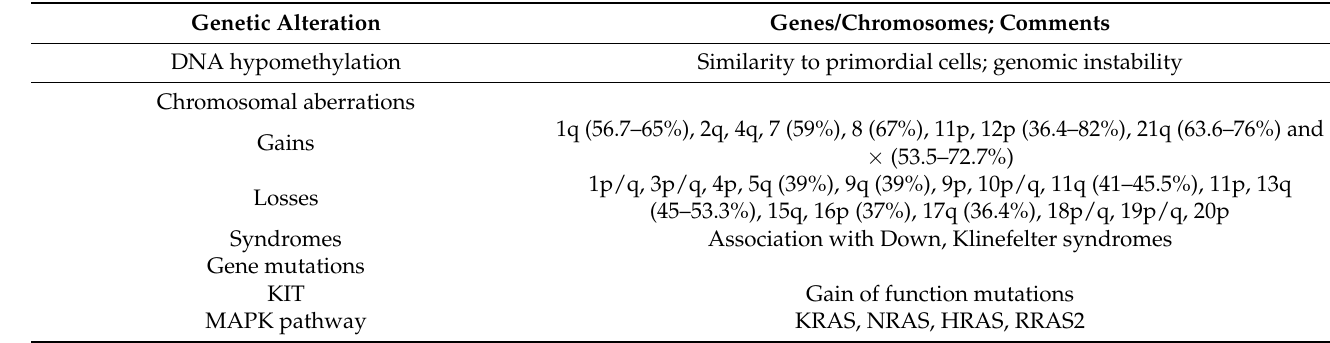
Table 3. Summary of basal genetic information in CNS